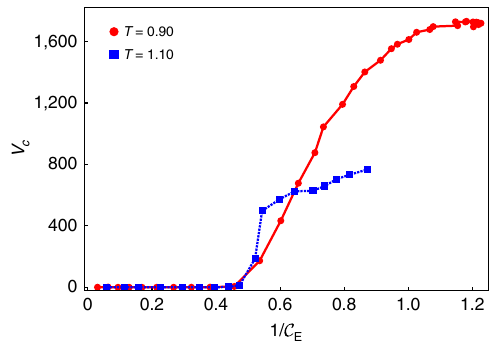
Figure 6 | Cavitation volume and Euler number. Dependence of the for the nematic LC cavitation volume on the inverse Euler number C (cid:3) 1 E (red circle) and isotropic LC (blue square).